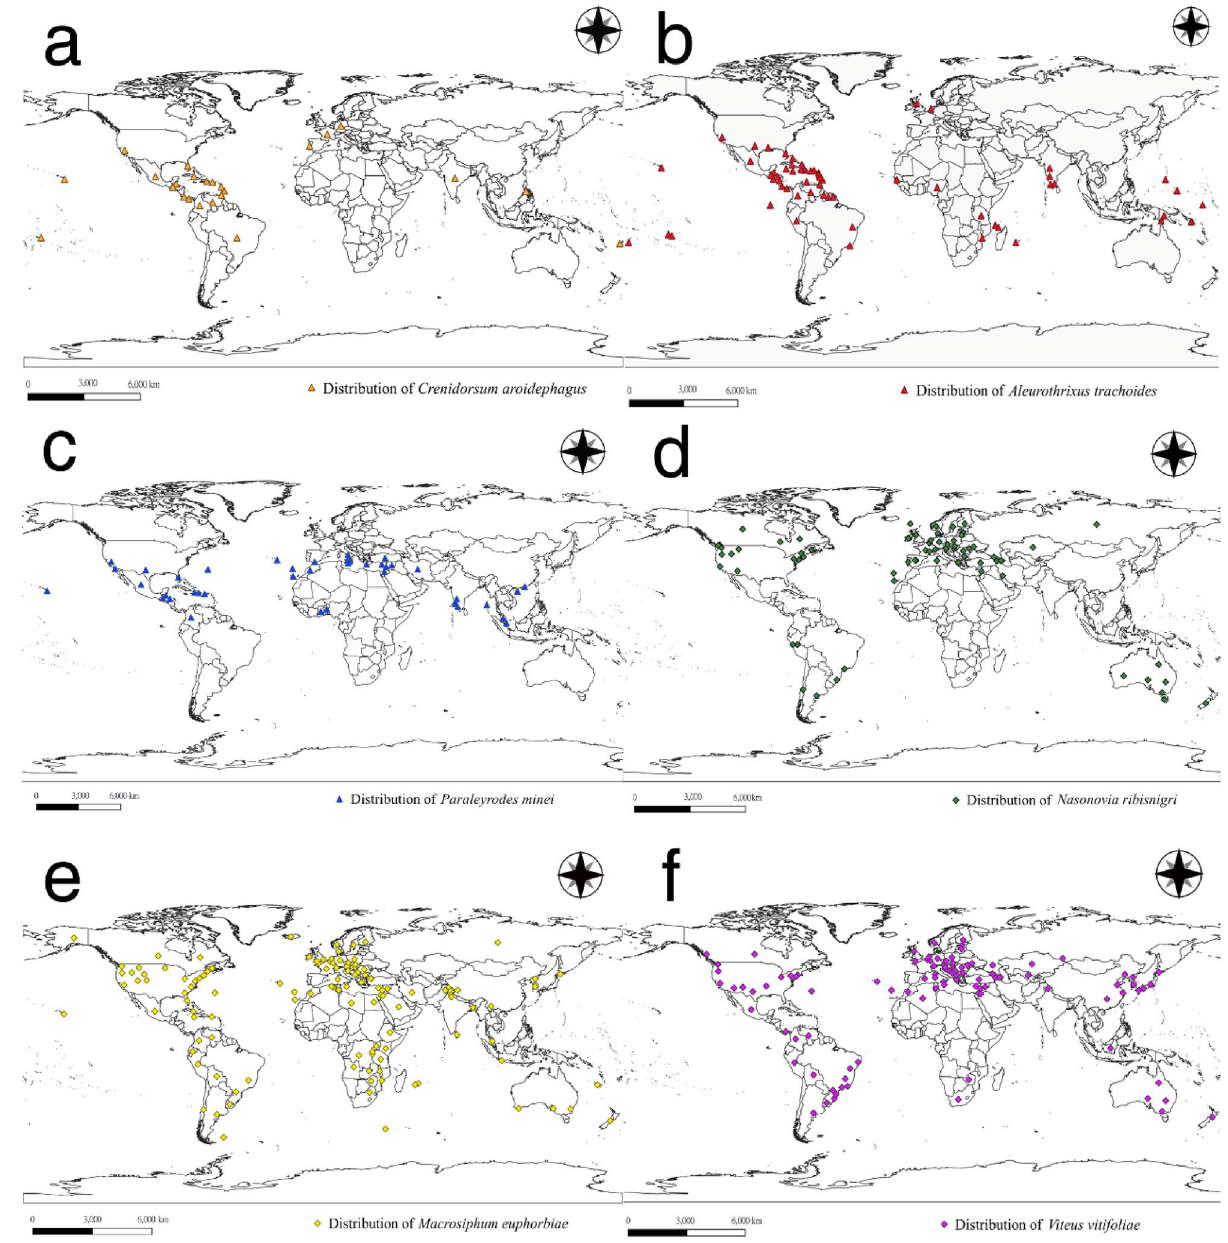
Figure 1. Distribution data of six important quarantine species: ( a ) Crenidorsum aroidephagus , ( b ) Aleurothrixus trachoides , ( c ) Paraleyrodes minei , ( d ) Nasonovia ribisnigri , ( e ) Macrosiphum euphorbiae , ( f ) Viteus vitifoliae . Triangle represent three whiteflies’ distribution points; diamond shapes represent three aphids’ distribution points. Maps were created using QGIS version 3.12.1 (www. qgis.